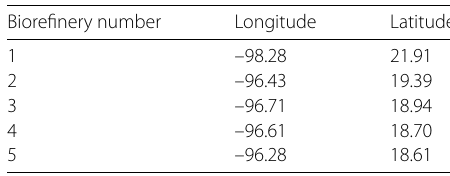
Table 1 Geographical locations of biorefineries